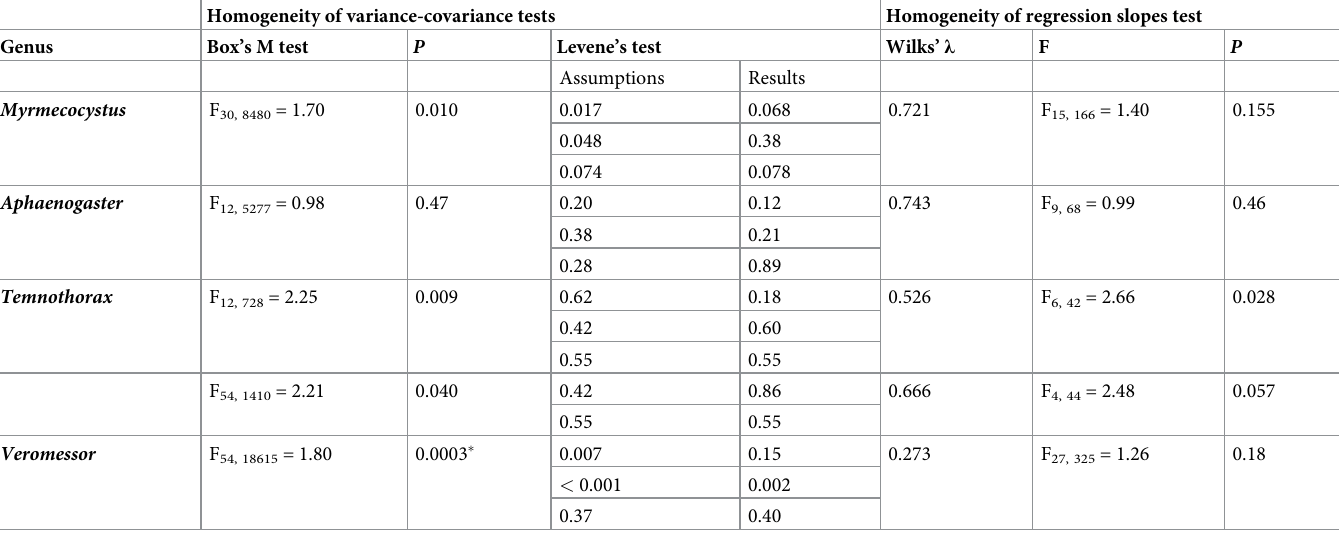
Table 3. Results for the homogeneity of variance-covariance and regression slopes assumptions in the MANCOVA. The MANCOVA for each genus was run twice; the first run tested homogeneity of variance-covariance and homogeneity of regression slopes assumptions, and the second run was for results of the model. For the Levene’s test, the first column gives the P value for the assumptions run, the second gives the P value for the results run. Values for these three lines are eye area, facet num- ber, and facet diameter, respectively. For Temnothorax , the first line is for all three variables, the second line is the model after deleting eye area (see text); values in the sec- ond line for the Levene’s test are for facet number and facet diameter,